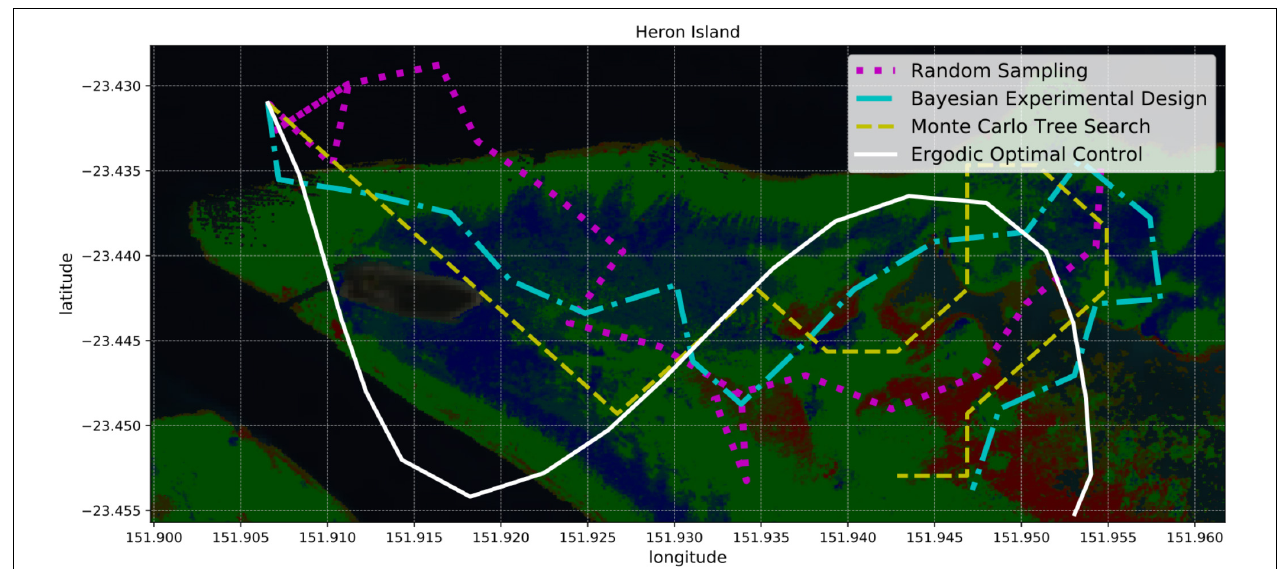
FIGURE 6 | Four sampling strategies for coral reef mapping: random sampling, Bayesian experimental design, Monte Carlo tree search, and ergodic optimal control. Random sampling is the simplest approach since it ignores how useful future samples might be. Bayesian experimental design provides a probabilistic framework for identifying the most informative samples and planning paths accordingly. Monte Carlo tree search combines random sampling with a tree search that focuses on the most promising actions. Ergodic optimal control not only selects informative samples, but also generates smooth trajectories that can be suitable for boats or AUVs.